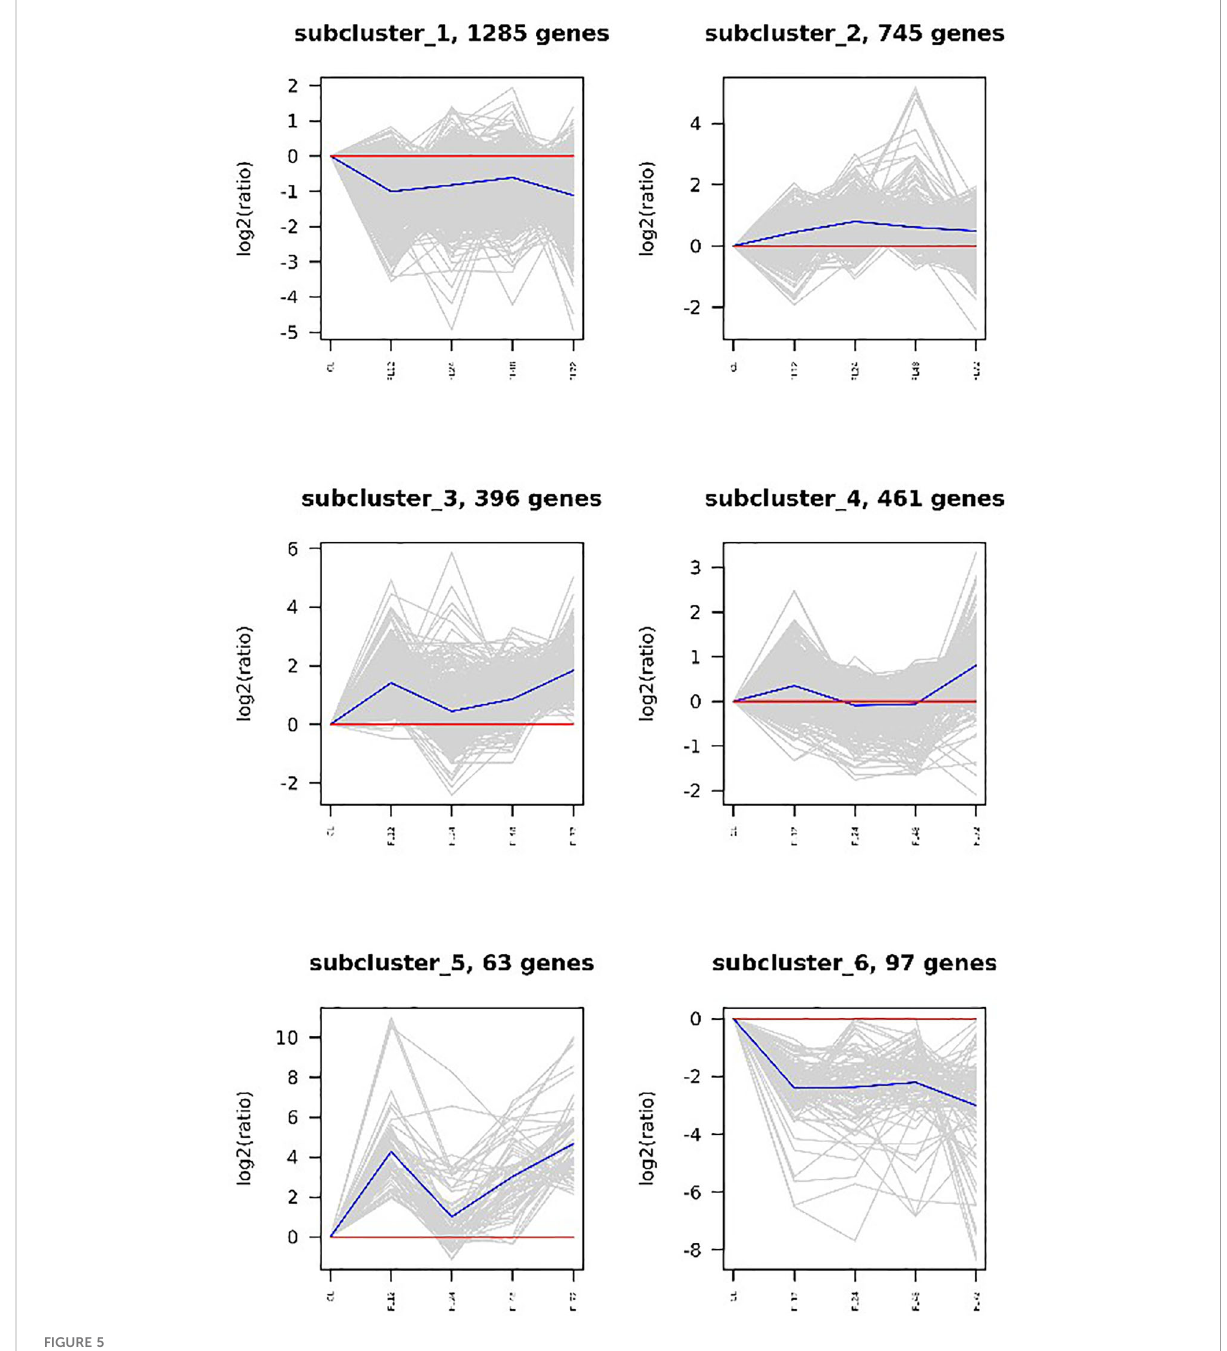
FIGURE 5 Clustering analysis of V. parahaemolyticus infection